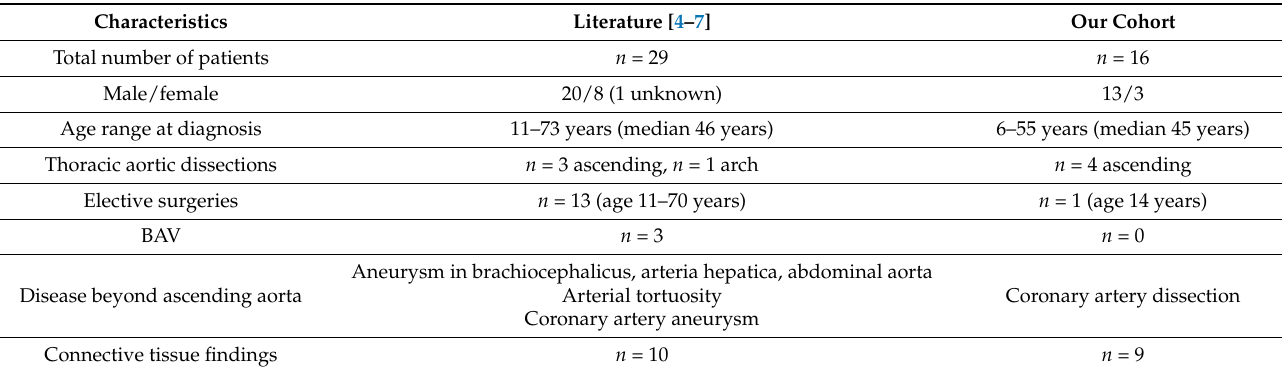
Table 1. Summary of clinical findings of our cohort of patients with LOX variants compared to literature.